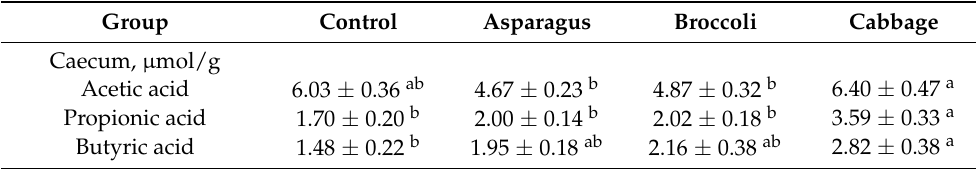
Table 4. Effects of vegetable powder on intestinal short-chain fatty acid concentrations of mice. Group